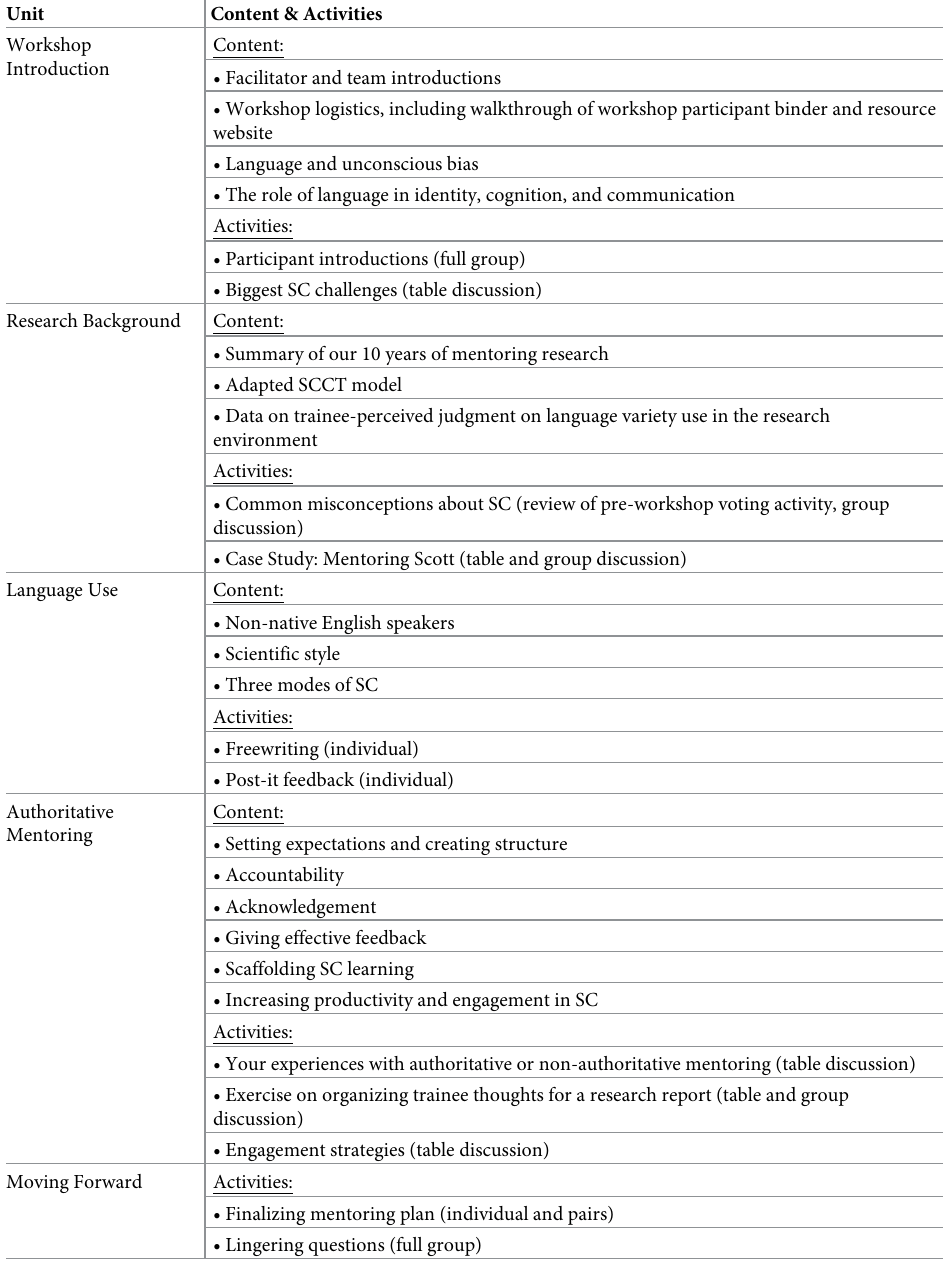
Table 1. SCOARE workshop units and